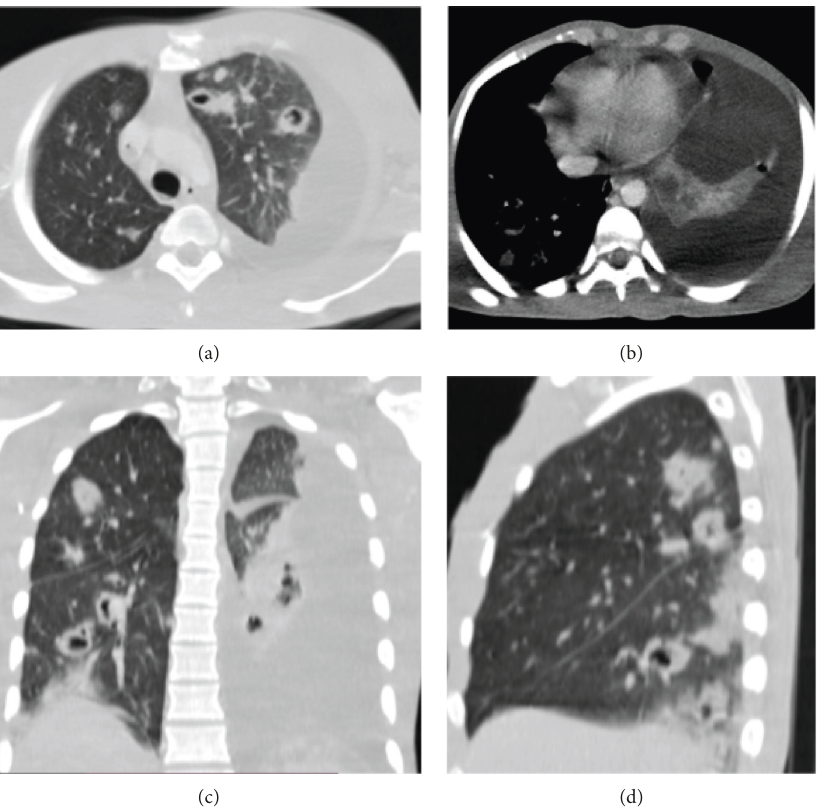
Figure 4: Thoracic CT scan with contrast injection. (a, c, and d) Axial, coronal, and sagittal views in the lung window showing multiple bilateral excavated nodules. (b) Axial view in mediastinal window showing left pleural fluid effusion with passive atelectasis of the lower